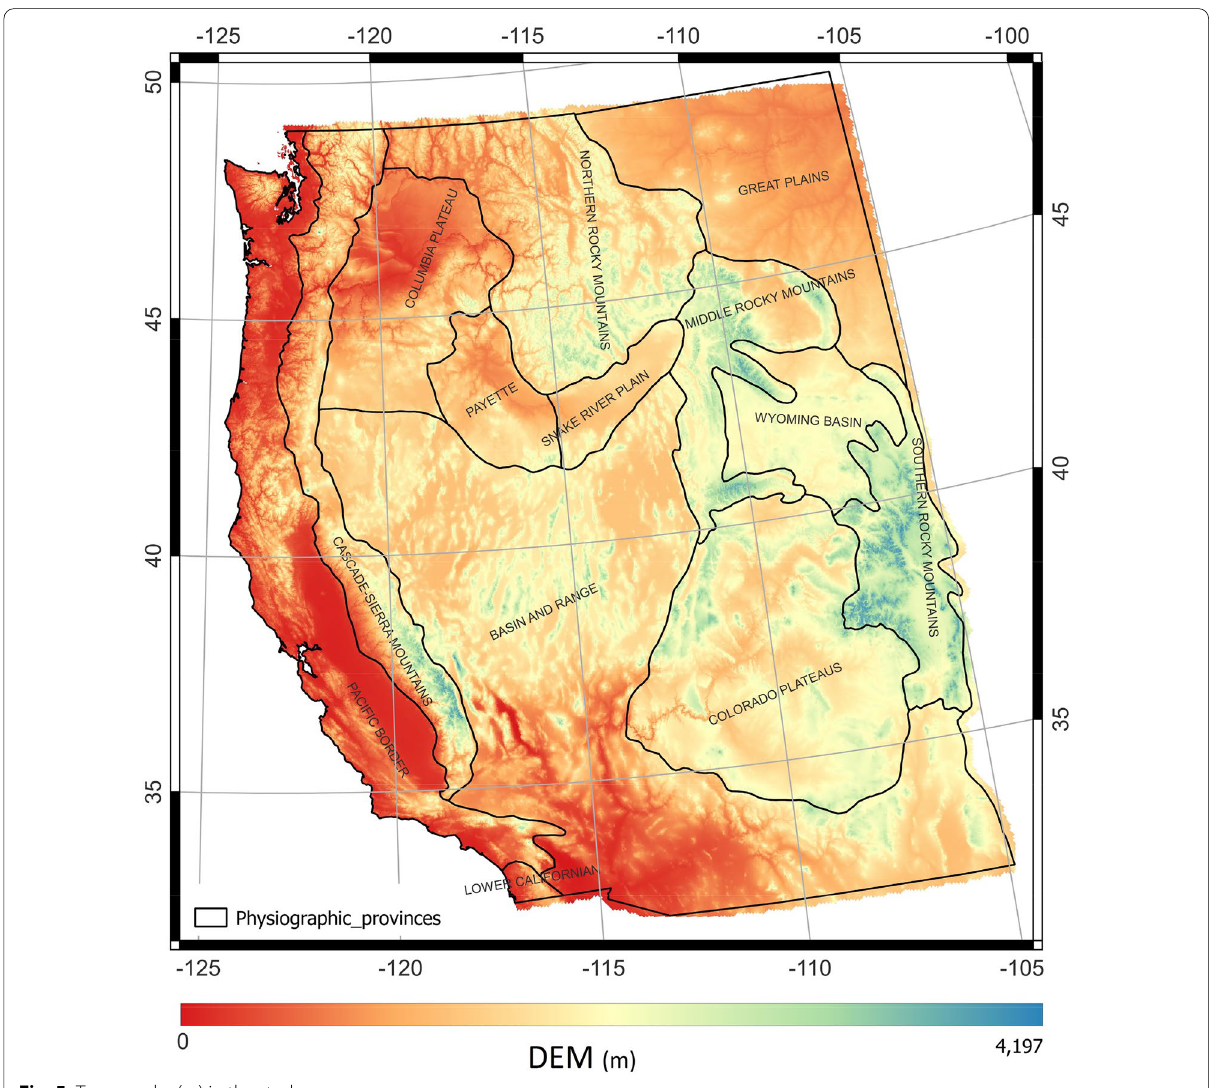
Fig. 5 Topography (m) in the study